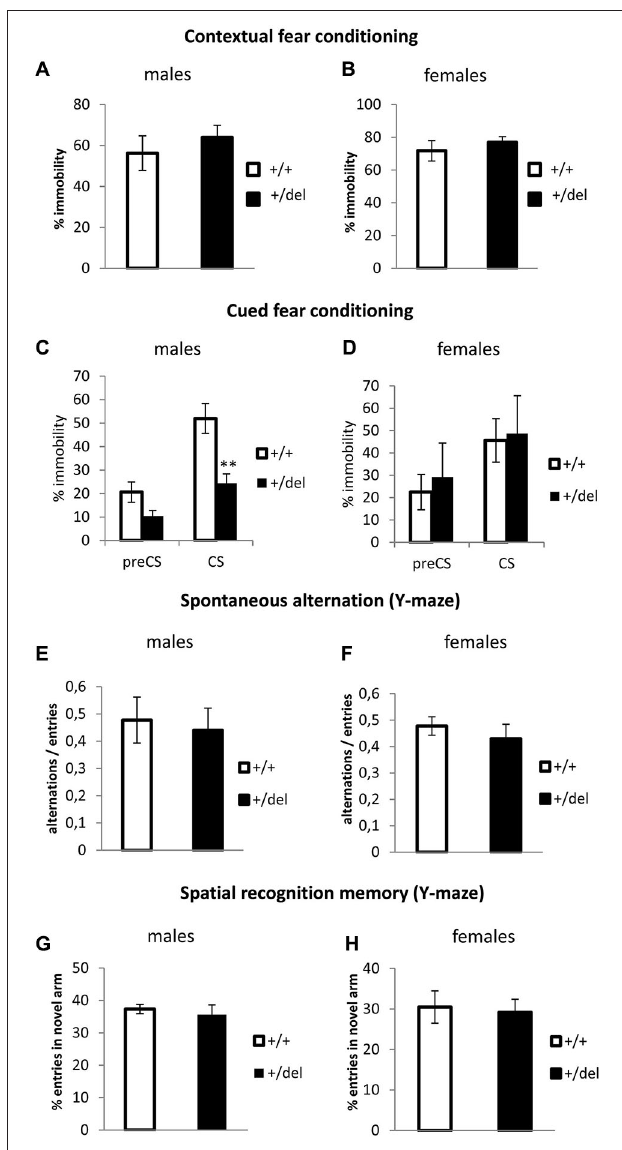
FIGURE 5 | Learning and memory test performance by heterozygous 129DISC1 Del mice. (A–B) Contextual fear conditioning. Percentage of immobility during the 6 min trial on the second day of test. Males ( (A) ; n + / + = 11, n + / del = 15) and females ( (B) ; n + / + = 6, n + / del = 7, right panel). (C–D) Cued fear conditioning. Percentage of immobility during the 3 min before of the presentation of tone (preCS) and during the 3 min length of acoustic cue (CS). Males ( (C) ; n + / + = 13, n + / del = 11) and females ( (D) ; n + / + = 10, n + / del = 5). (E–F) Spontaneous alternation was measured in a Y-maze. Data are represented as the ratio between the number of overlapping triple alternate entries and total possible alternations in males (E) and females (F) . (G–H) Spatial recognition memory was measured in a Y-maze. Data are represented as the percentage of entries in the novel arm for males (G) and females (H) . Number of animals for (E–H) is: males ( n + / + = 6, n + / del = 19) and females ( n + / + = 15, n + / del = 19).